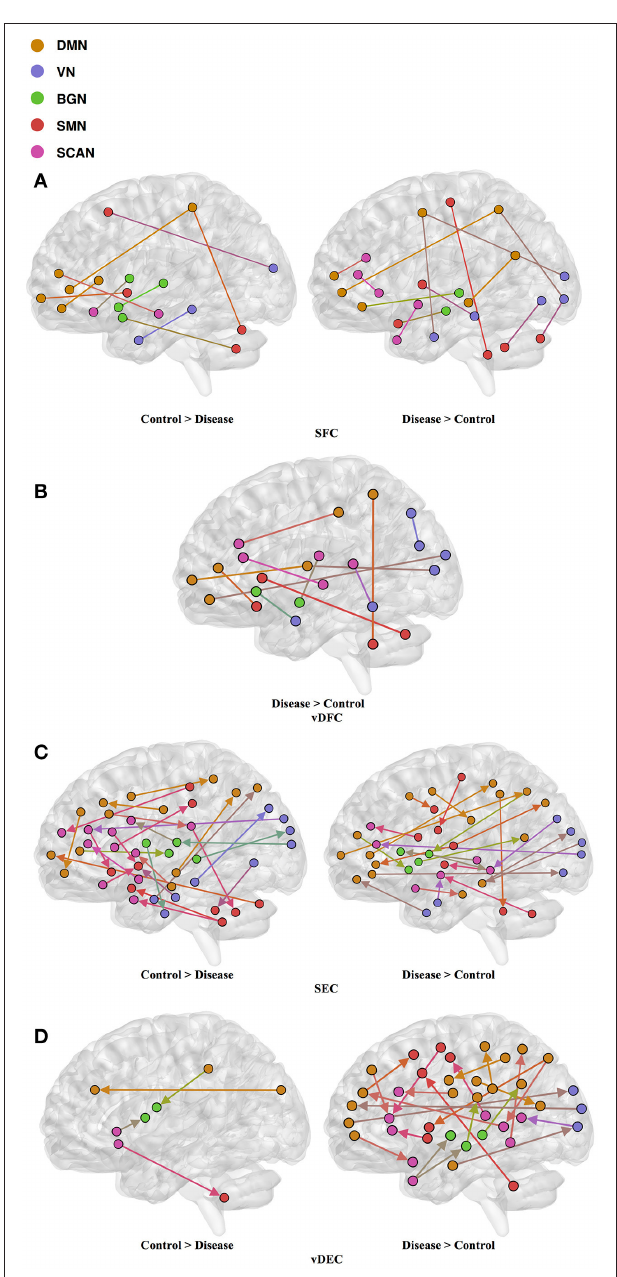
FIGURE 6 | (A) SFC; (B) vDFC; (C) SEC; (D) vDEC features. selected by GA and hierarchical (ADHD). Selected features were split into two groups, i.e., (1) control > disease (ADHD-C and ADHD-I) and (2) disease > control. DMN, Default mode network; VN, Visual network; BGN, Basal ganglia network; SMN, Sensory motor network; SCAN, Semantic cognition and attention network.